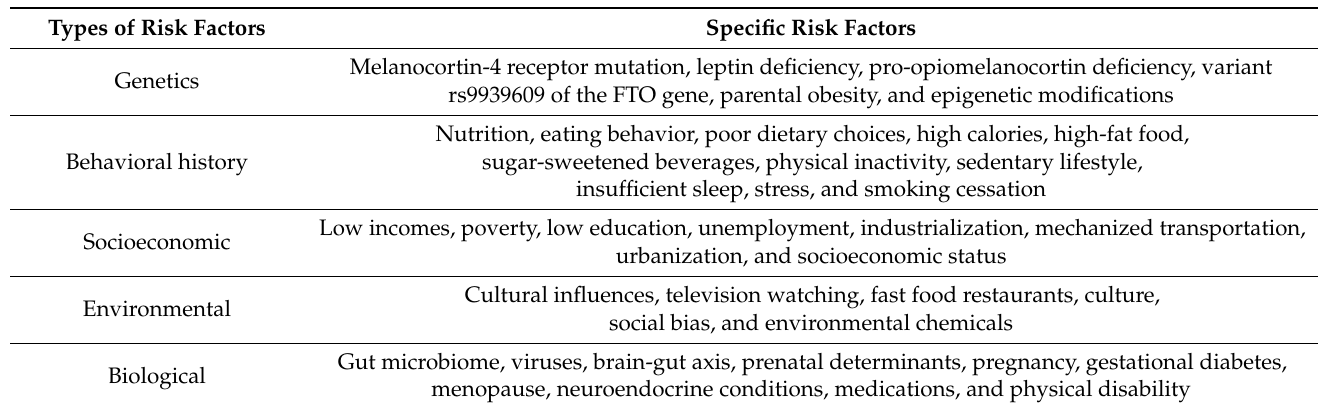
Table 1. Factors associated with the obesity